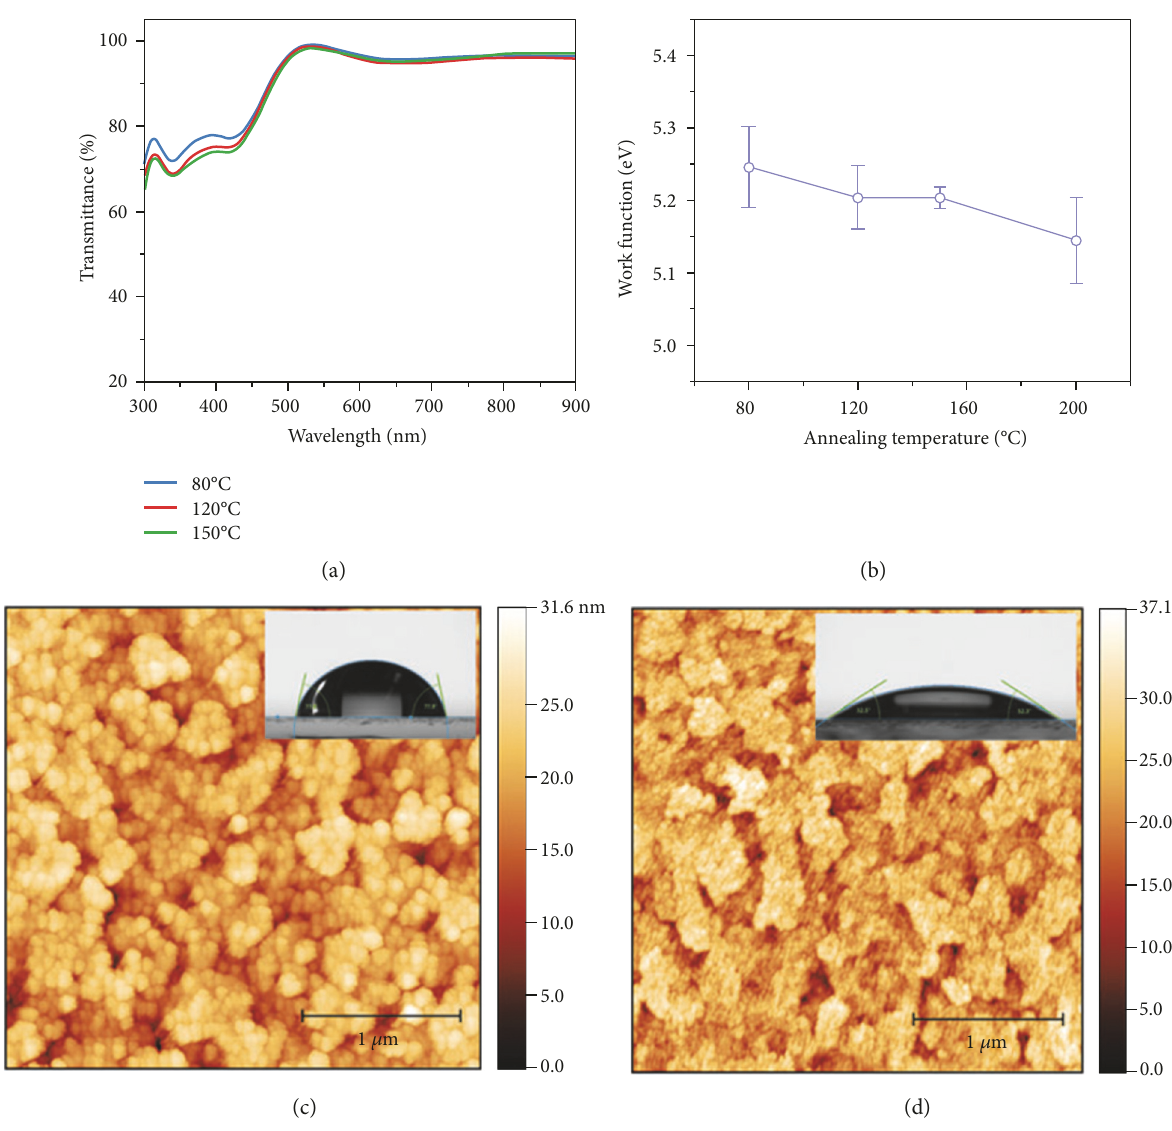
Figure 10: (a) Transmittance spectra of V O temperatures on ITO substrates. (c) AFM images of a bare ITO substrate. (d) AFM images of a VO permission from